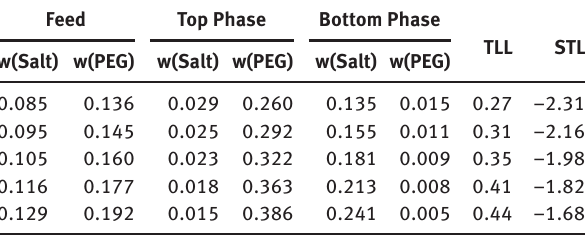
Table 2: Mass fraction of feed, top and bottom phases for PEG 10000 + Sodium tartrate + H O at 298.15 K and 84 kPa, and the 2 calculated TLL and STL. a